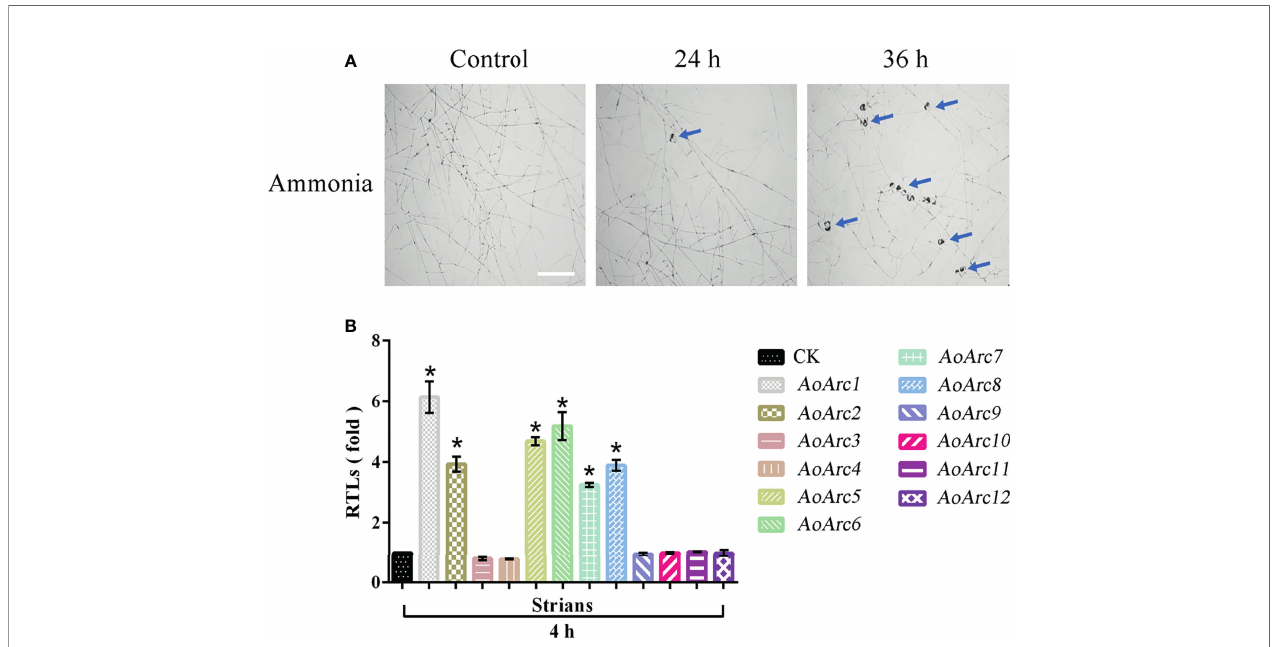
FIGURE 2 | Ammonia-induced expression analysis of AoArc genes in Arthrobotrys oligospora . (A) Ammonia can induce A. oligospora to produce traps. With the extension of the ammonia incubation time, the number of traps produced increased signi fi cantly, and the blue arrow represents the trap (bar = 500 m m). (B) Analysis of the expression of arrestin-related genes after 4 h of ammonia induction. Among them, the samples were cultured at 28°C for 4 h, that is, the arrestin expression of the samples without ammonia induction as a standard (CK), which was used for the statistical analysis of RTL. Each experiment was performed three times. Error bars: standard deviation; asterisk: signi fi cant difference between ammonia treatment and no treatment (Tukey ’ s HSD, p < 0.05).